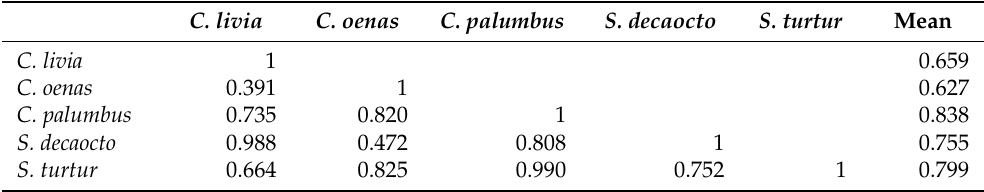
Table 1. Habitat overlap among five Columbidae species (feral pigeon ( Columba livia forma domestica ), stock dove ( Columba oenas ), wood pigeon ( Columba palumbus ), Eurasian collared dove ( Streptopelia decaocto ), and European turtle dove ( Streptopelia turtur )) was estimated as a similarity index based on land use composition and two landscape metrics at each site where the species were present. Value of one suggests that the species are completely sharing resources. Value of zero indicates that the species do not share any resources. Mean—mean habitat overlaps for each Columbidae